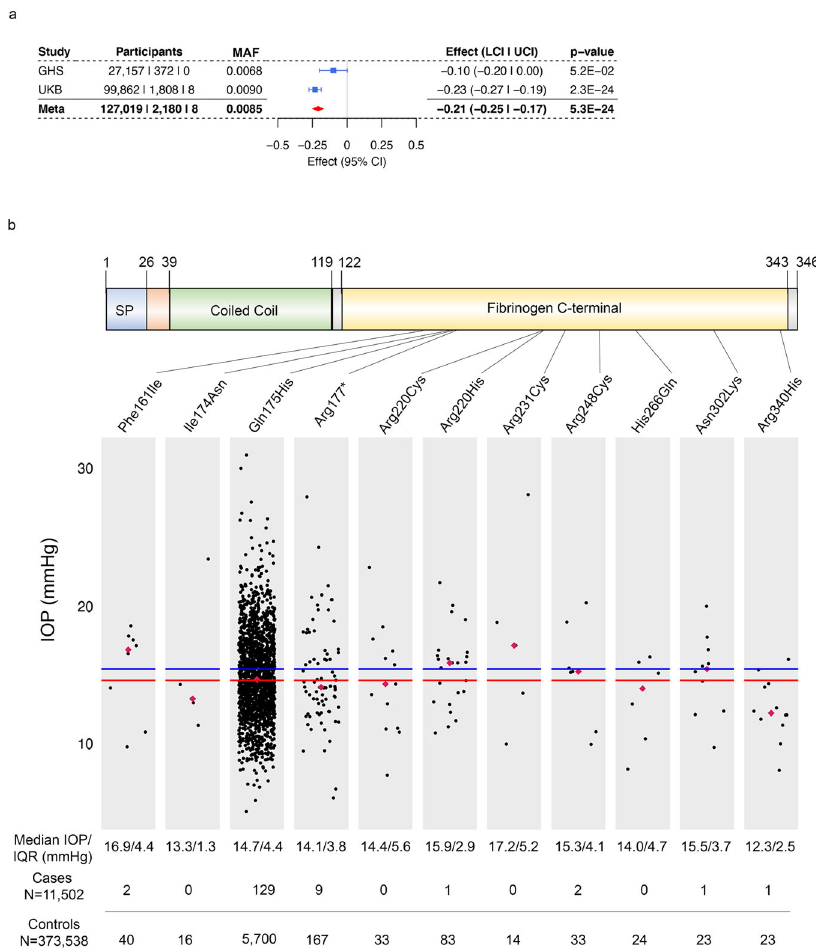
Fig. 1 An aggregate of rare (MAF< 1%) loss-of-function and missense variants in ANGPTL7 is associated with IOP. a Association of an aggregate of 63 pLOF and deleterious (based on 5 prediction algorithms) missense variants in ANGPTL7 with reduced IOP in 129,207 individuals of European descent. b Missense and predicted loss-of-function (pLOF) variants in ANGPTL7 and IOP levels in individuals of European descent from UKB. The plots represent Goldmann-correlated IOP (IOPg; mean of both eyes) levels in carriers of 1 pLOF and 10 missense variants in ANGPTL7 that are predicted deleterious by fi ve different algorithms and have at least fi ve carriers amongst the 101,678 exome-sequenced individuals with IOP measurements in the UK Biobank. The median IOP level across carriers of all 49 pLOF and predicted-deleterious missense ANGPTL7 variants (14.64 mmHg) is indicated by the red line, and the median IOP in non-variant carriers (15.46 mmHg) is indicated by the blue line. Magenta diamonds mark the median IOP in carriers of each variant. Beneath the plots is the median and interquartile range (IQR) of IOP and the numbers of variant carriers diagnosed with glaucoma or controls in UKB ( n = 385,040). GHS Geisinger DiscovEHR, UKB UK Biobank, MAF Minor allele